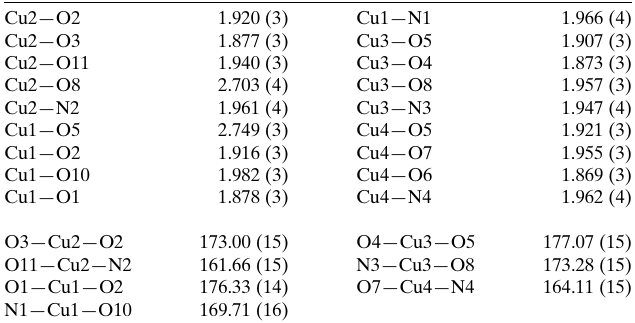
Table 1 Selected geometric parameters (A˚ , (cid:5)